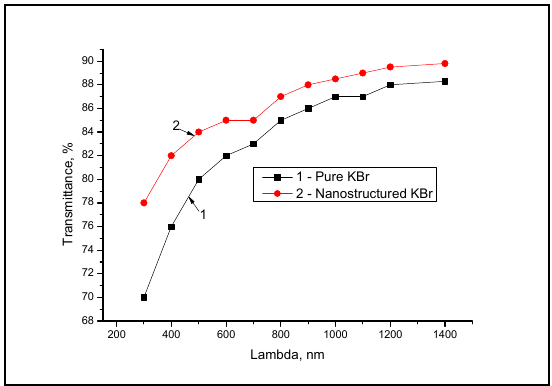
Figure 3. KBr sample transmittance in the UV–VIS spectral range.